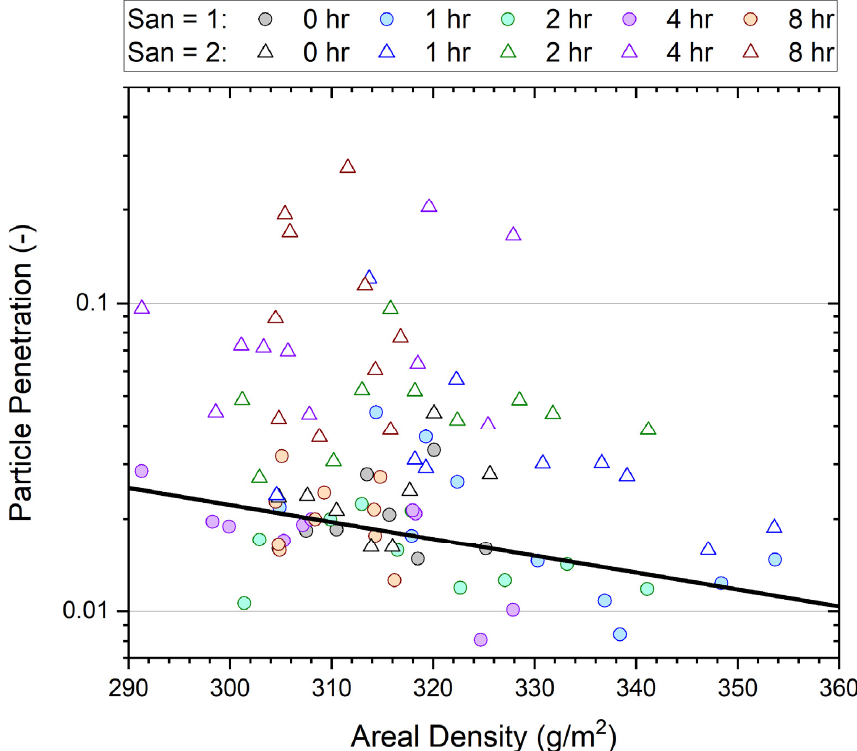
Figure 5. Penetration (P 0.3 ) of samples before and after wearing for 0–8 h as a function of areal density (basis weight). Filter tests were conducted after the first (San = 1) and second (San = 2) heat sanitization treatments. A linear fit of the logarithm of the average particle penetration Log(P) over areal density for unworn media (San = 1) is shown to illustrate the expected trend. The dry weight ratios (worn/unworn) for each sample (including 0 h for unworn controls) are given in Figure 6. These weights were measured immediately after filter samples were removed from the oven after the sanitizing treatment.